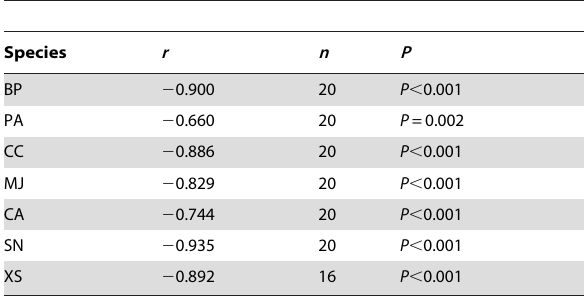
Table 5. The correlations between malondialdehyde (MDA) concentration for each species and the actual species richness in the experimental communities.